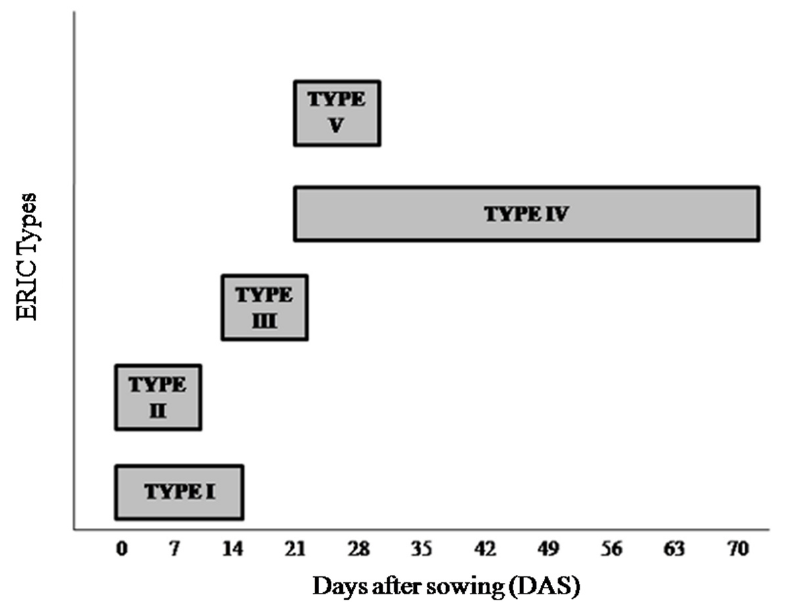
Figure 2. Depiction of recurrence of ERIC-types at different growth stages of Pennisetum glaucum under field growth conditions.